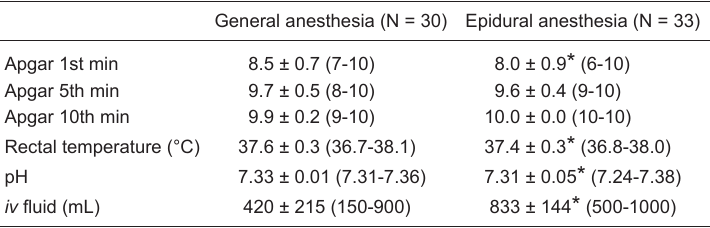
Table 2. Apgar scores, rectal temperatures and umbilical vein pH values of new- borns and iv fluid